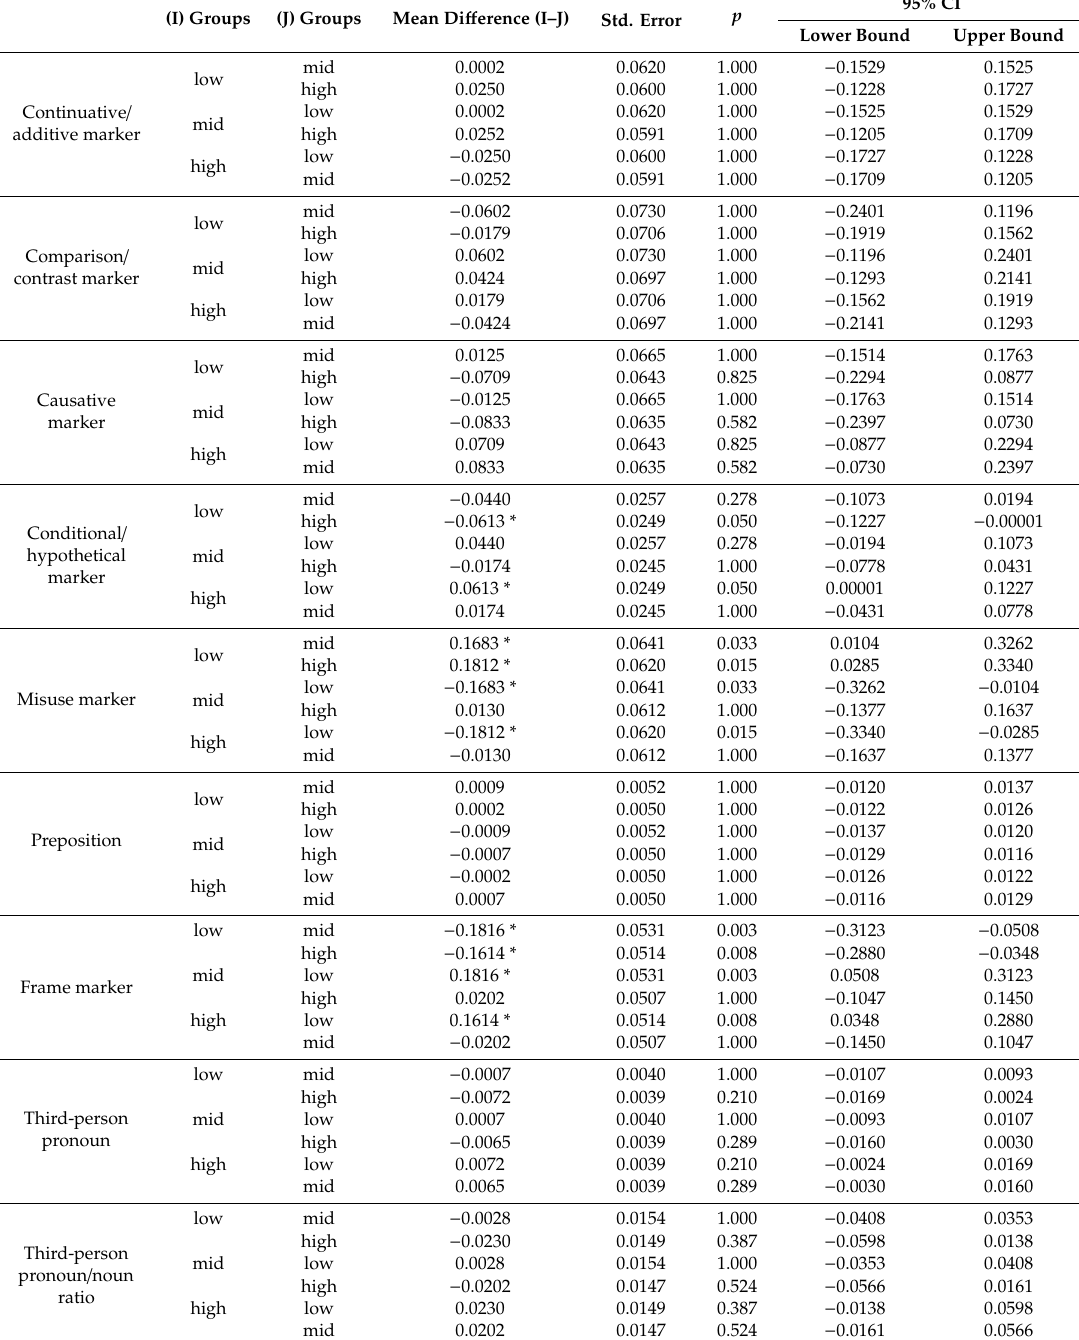
Table A1. Multiple comparisons with Bonferroni